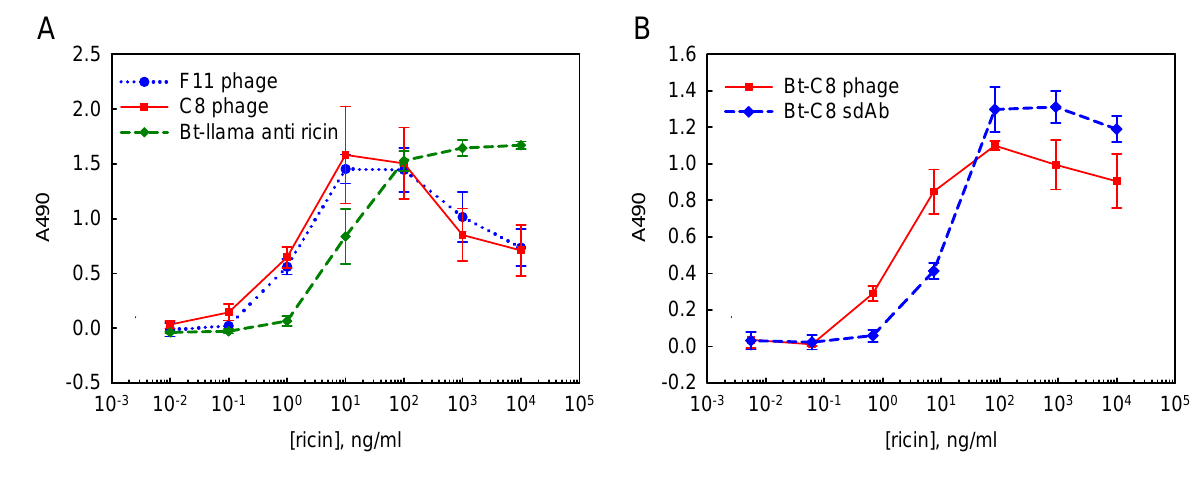
Figure 3 . ELISA based ricin detection. Phage-displayed sdAb and llama polyclonal anti- ricin IgG were compared as the reporter reagents using a llama anti-ricin capture surface. Panel A shows results of phage-displayed sdAb followed with an anti-M13 –HRP conjugate for color generation and biotinylated llama anti-ricin IgG followed with a Streptavidin – HRP conjugate. Panel B show the results using biotinylated phage-displayed sdAb and biotinylated soluble sdAb reporter elements followed with a Streptavidin –HRP conjugate. Data is plotted as the average of 3 wells, with error bars representing the standard deviation. Results indicate phage-displayed sdAb can act as highly sensitive detection